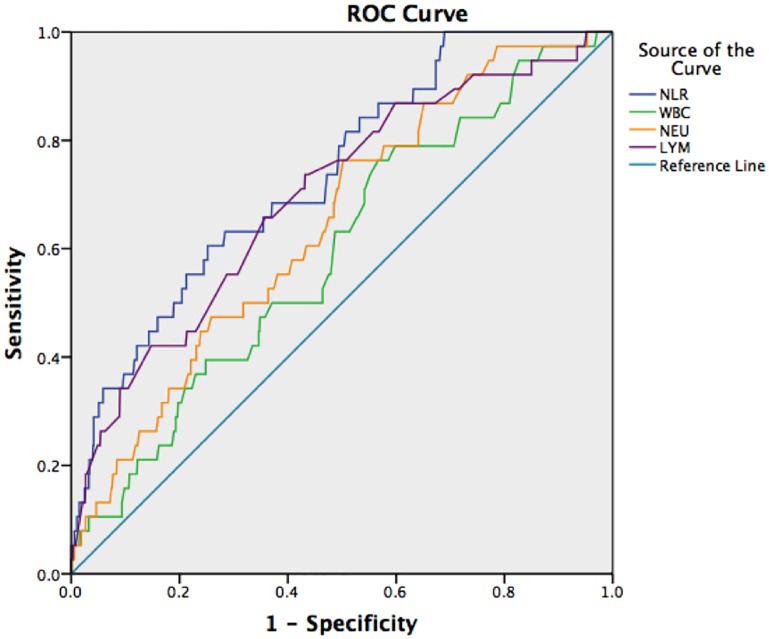
ROC curves of NLR, WBC, NEU, and LYM to predict the 28-day mortality rate.